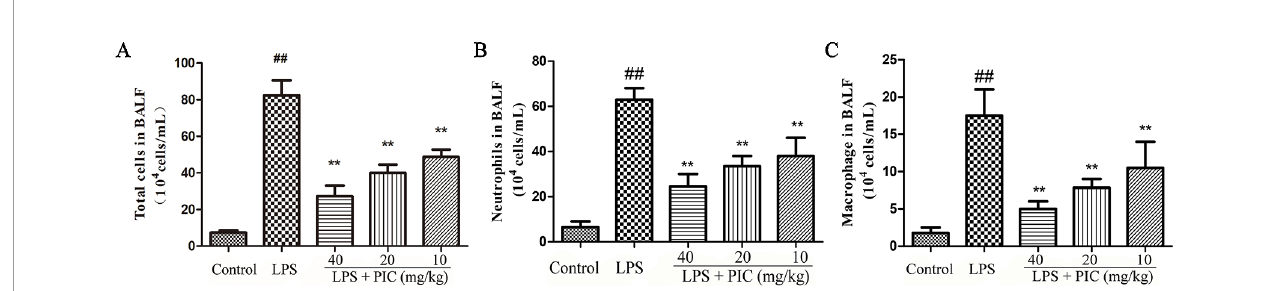
FIGURE 2 | The total cells and immune cells count of bronchoalveolar lavage fl uid (BALF.) After centrifuging the BALF, the cell pellet was used to count the numbers of (A) total cells, (B) neutrophil, and (C) macrophage by a hemocytometer. ## p < 0.01 is signi fi cantly different from the control group; ** p < 0.01 are signi fi cantly different from the lipopolysaccharide (LPS) group.